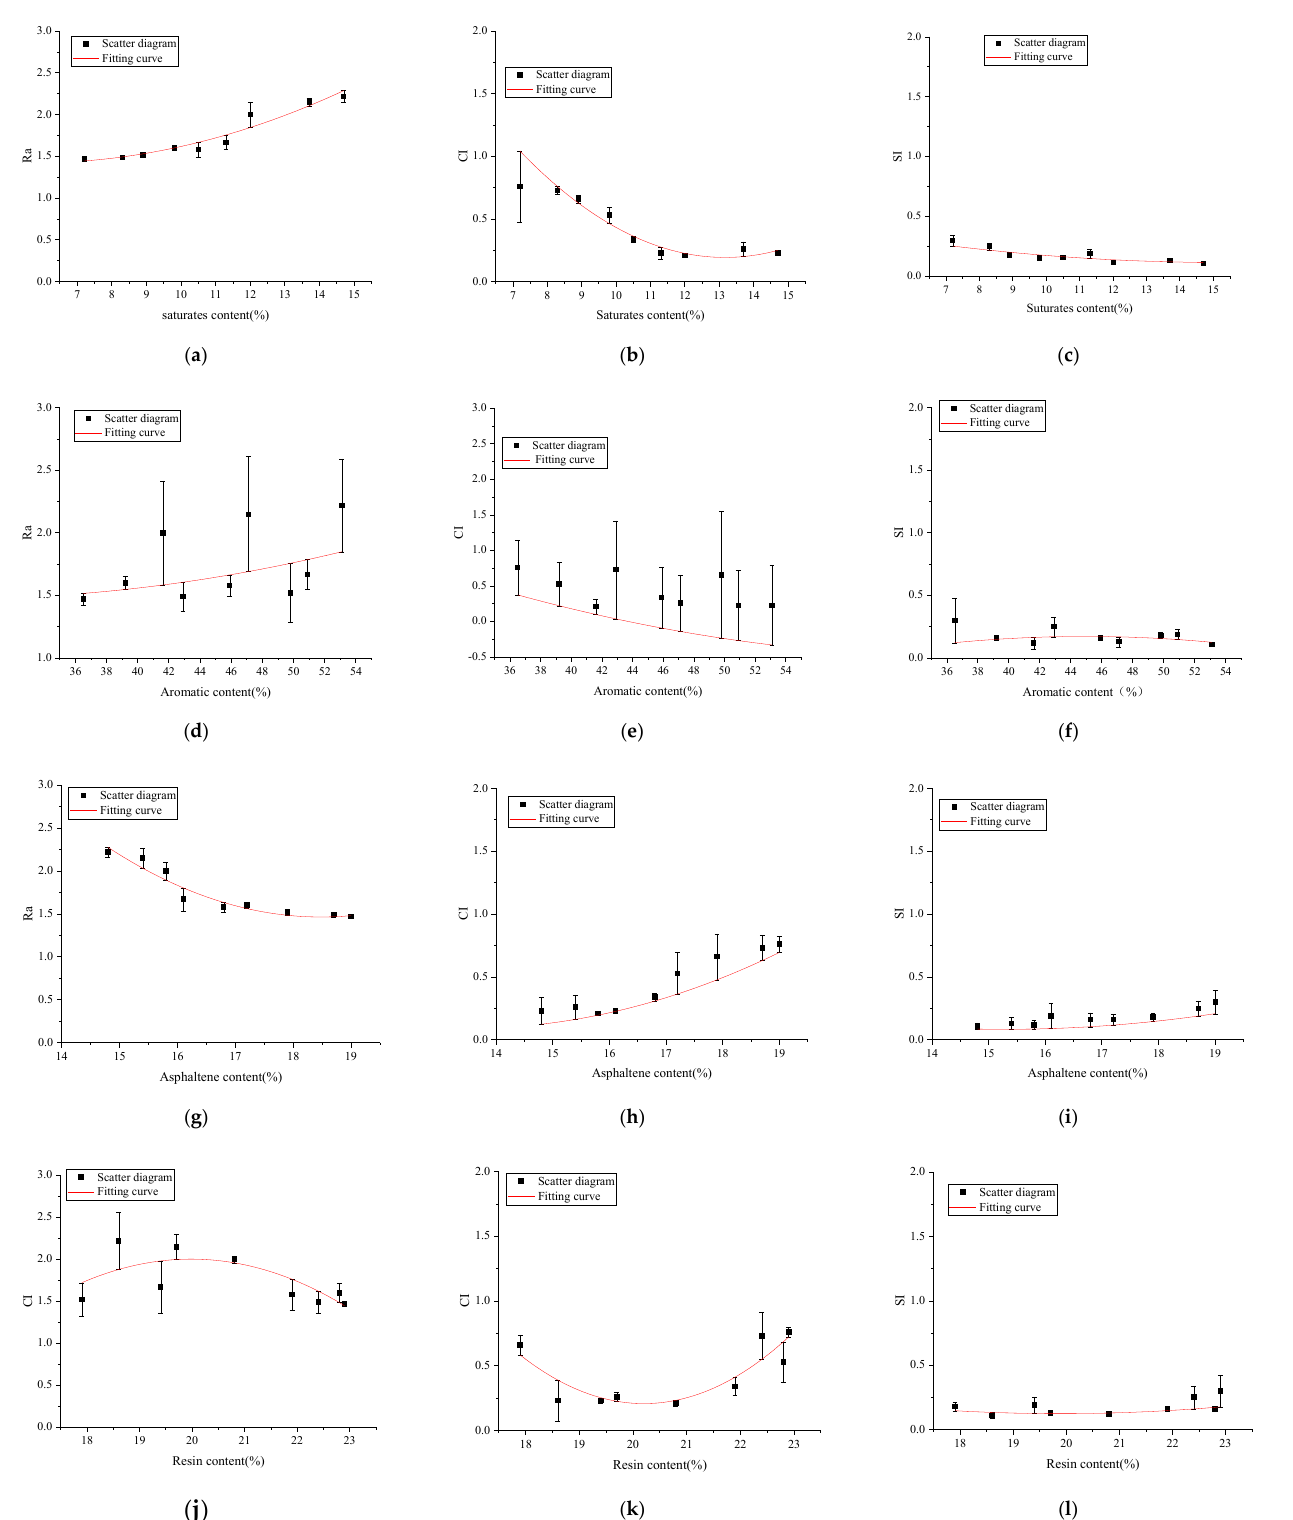
Figure 8. Fitting diagram of regenerated aging asphalt components and microscopic characteristic model: ( a ) Fitting effect of saturation content and Ra; ( b ) fitting effect of saturation content and CI; ( c ) fitting effect of saturation content and SI; ( d ) fitting effect of aromatic content and Ra; ( e ) fitting effect of aromatic content and CI; ( f ) fitting effect of aromatic content and SI; ( g ) fitting effect of asphaltene content and Ra; ( h ) fitting effect of asphaltene content and CI; ( i ) fitting effect of asphaltene content and SI; ( j ) fitting effect of resin content and Ra; ( k ) fitting effect of resin content and CI; ( l ) fitting effect of resin content and SI.